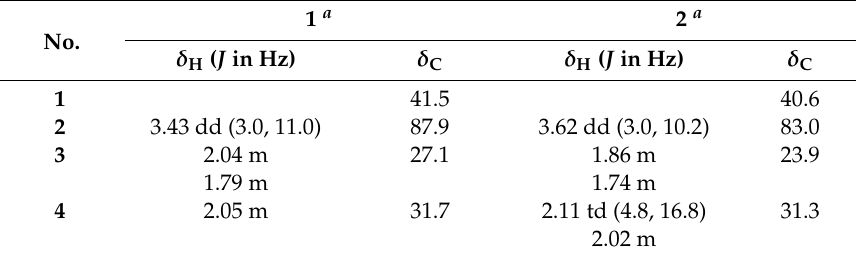
Table 1. NMR Spectroscopic data for compounds 1 and